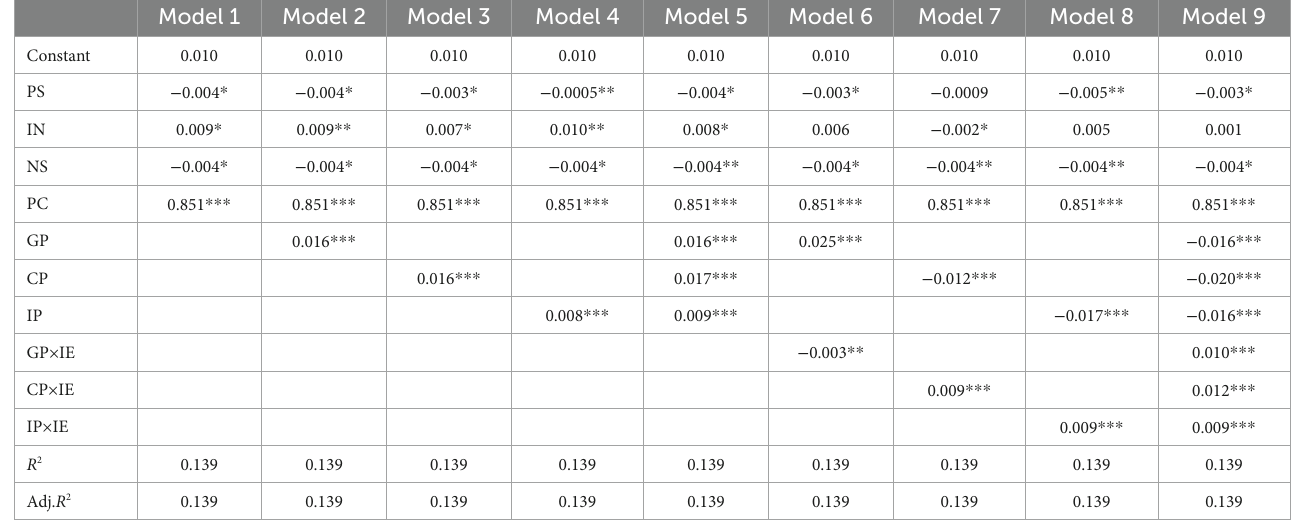
TABLE 2 Regression results regarding the influence of multidimensional proximities and intraorganizational collaboration network inefficiency based on the QAP